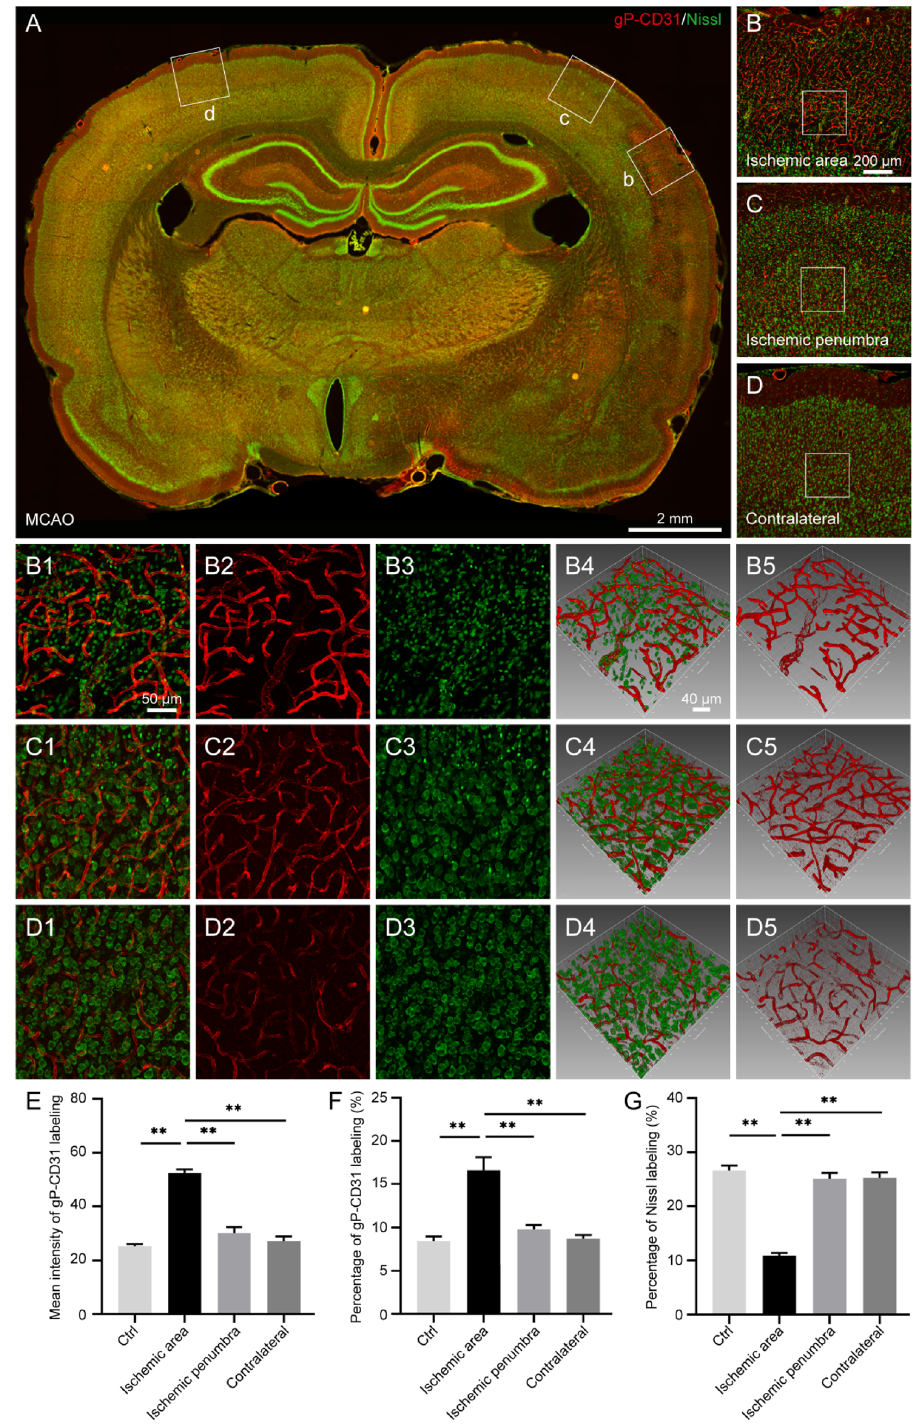
Figure 3. Distribution of vascular and cellular labeling with goat polyclonal anti-CD31 (gP-CD31) and Nissl in the rat brain with ischemia/reperfusion. ( A ) Representative montage view from the coronal section of ischemic brain immunofluorescently labeled with gP-CD31 and Nissl. ( B – D ) Magnified photographs from panel ( A ) (box-indicated regions) showing the distribution of vascular and cellular labeling in the cerebral cortex, including ischemic region ( B ), ischemic penumbra ( C ), and matching contralateral region ( D ). ( B1 – B5 ), ( C1 – C5 ), ( D1 – D5 ) The higher magnified photographs from the panel ( B – D ) (box-indicated regions) showing the detailed vascular and cellular labeling ( B1 , C1 , D1 ) separately with gP-CD31 ( B2 , C2 , D2 ) and Nissl ( B3 , C3 , D3 ), and further adjusted in a sloping pattern with three-dimensional reconstruction ( B4 – B5 , C4 – C5 , D4 – D5 ). ( E , F ) Quantitative analysis of the labeling intensity ( E ) and the percentage ( F ) of gP-CD31 (n = 4 rats, 12 fields per region, ** P < 0.05). ( G ) Quantitative analysis of the percentage of Nissl labeling (n = 4 rats, 12 fields per region, ** P < 0.05). Scale bars: 2 mm in ( A ), 200 μm in ( B – D ), 50 μm in ( B1 – D1 ), ( B2 – D2 ), ( B3 – D3 ), and 40 μm in ( B4 – D4 ), ( B5 – D5